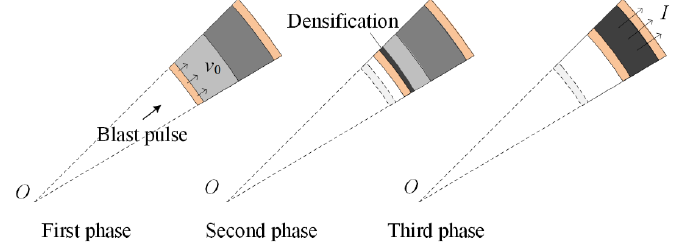
Figure 2. Three response phases for the blast response of a sandwich-walled cylinder.